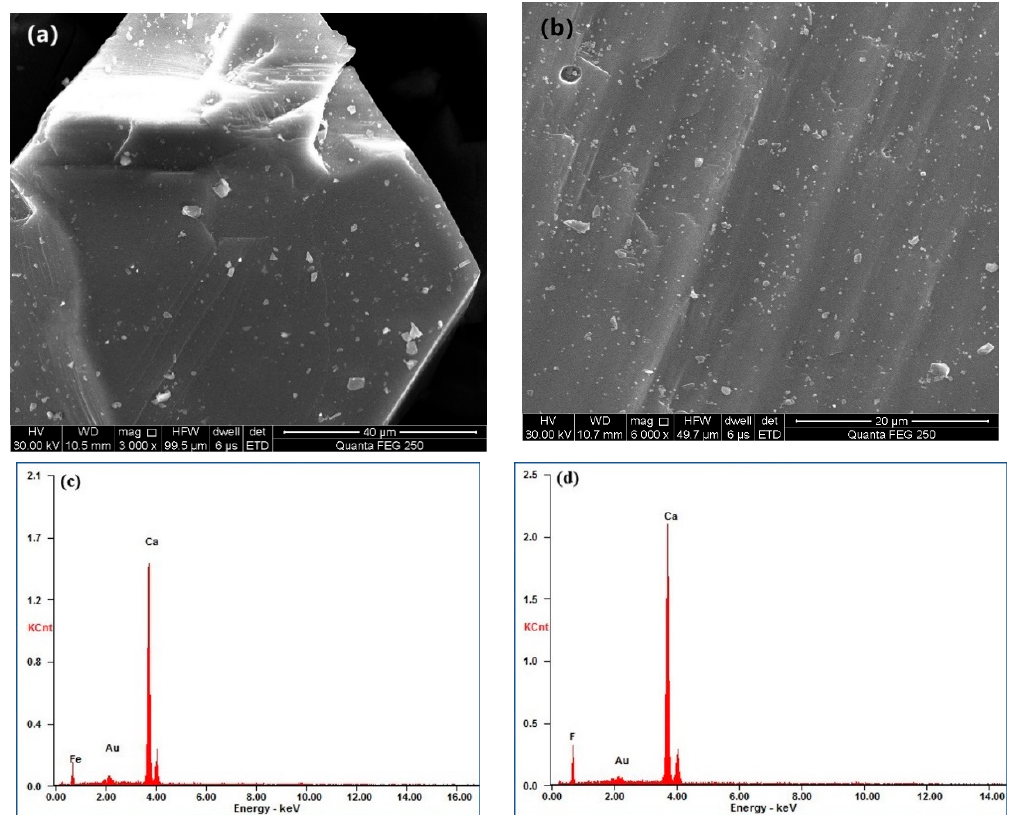
Figure 5. Scanning electron micrograph before ( a ) and after ( b ) fluorite addition and EDS diagram before ( c ) and after ( d ) fluorite addition.